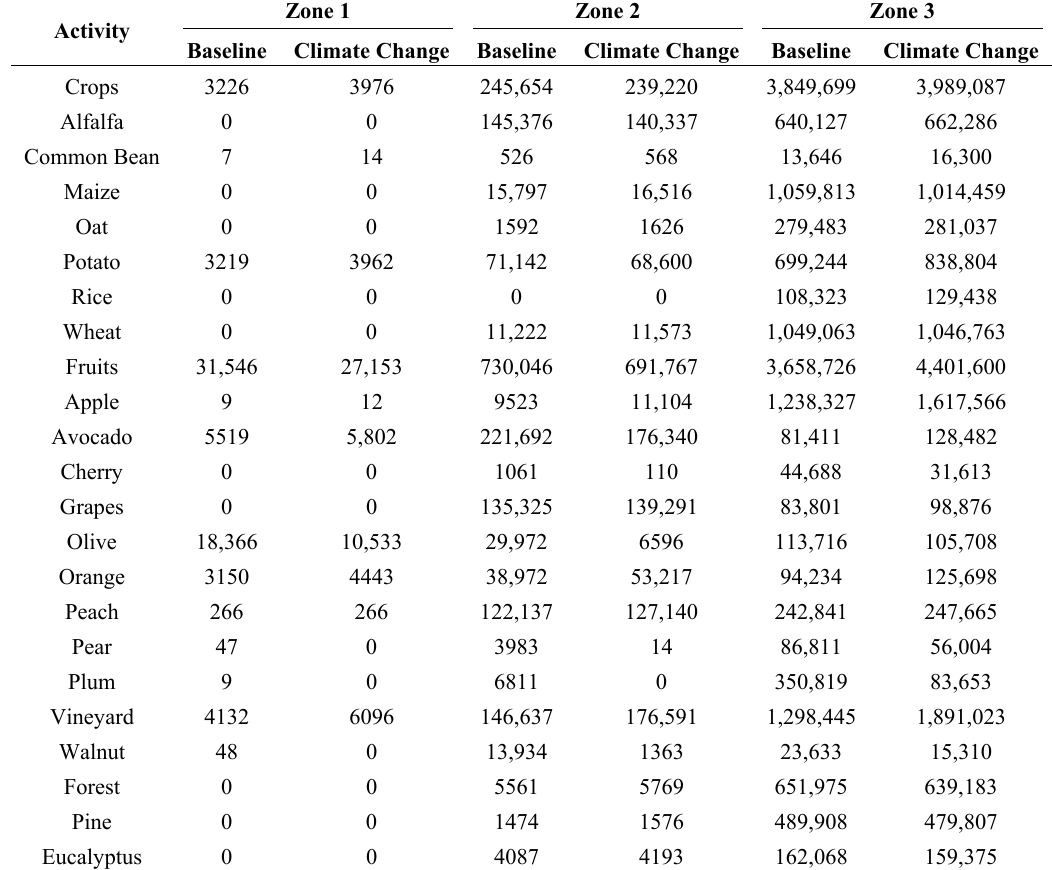
Table 2. Agricultural Production by Zone and Activity (ton).